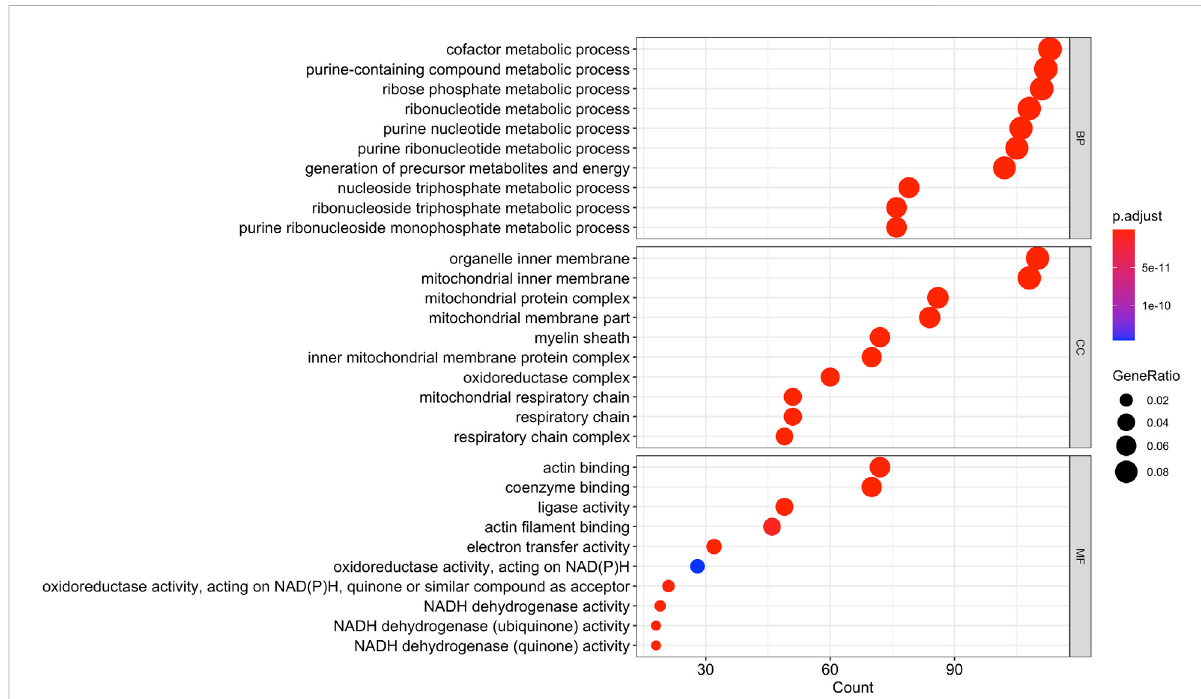
FIGURE 2 Gene Ontology analysis of the 1,277 differentially regulated proteins (q-value < 0.05) between the monocrotaline right ventricle (RV) and sham RV revealed an enrichmentin biologicalprocesses involved in purine and ribose metabolism, cellular component termsinvolving mitochondrial and respiratory chain, and molecular functions involving cellular